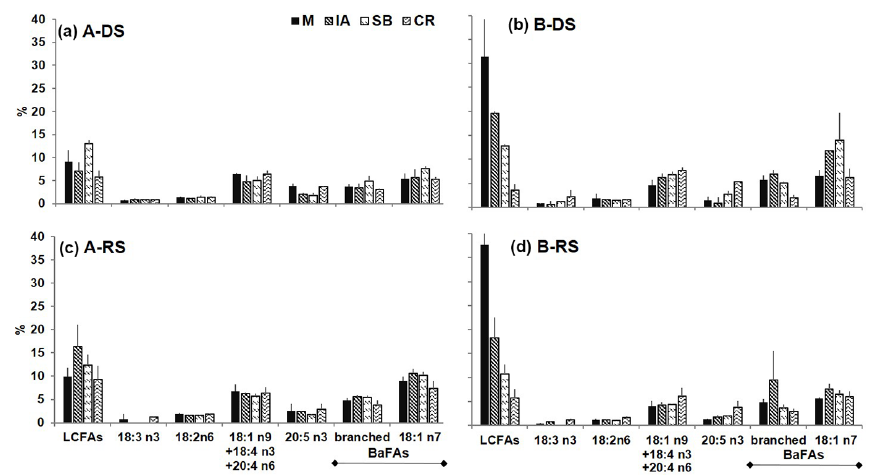
Figure 6. Mean ( ± SD) relative abundance of biomarker FAs (% of total FAs) in SOM. Selected biomarkers include LCFAs, 18:3 n3 and 18:2 n6 for mangroves, 18:2 n6 and 18:3 n3 for seagrasses, 18:2 n6 for agricultural runoff, 18:1 n9 + 18:4 n3 + 20:4 n6 for brown macroalgae, 20:5 n3 for red macroalgae and diatoms, branched FA, and 18:1 n7 for